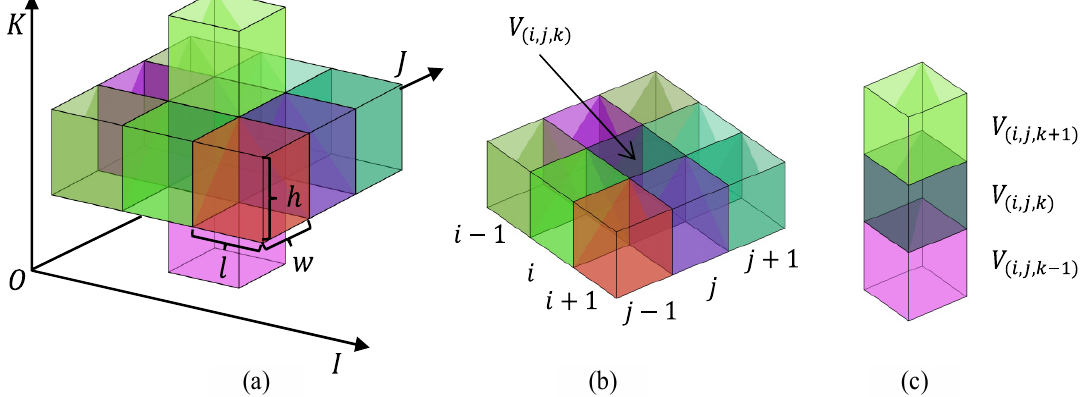
Figure 4. Voxel used in this study. ( a ) Coordinate system of voxel; ( b ) 8-neighbors in the same layer; ( c ) 3-neighbors in the vertical direction.